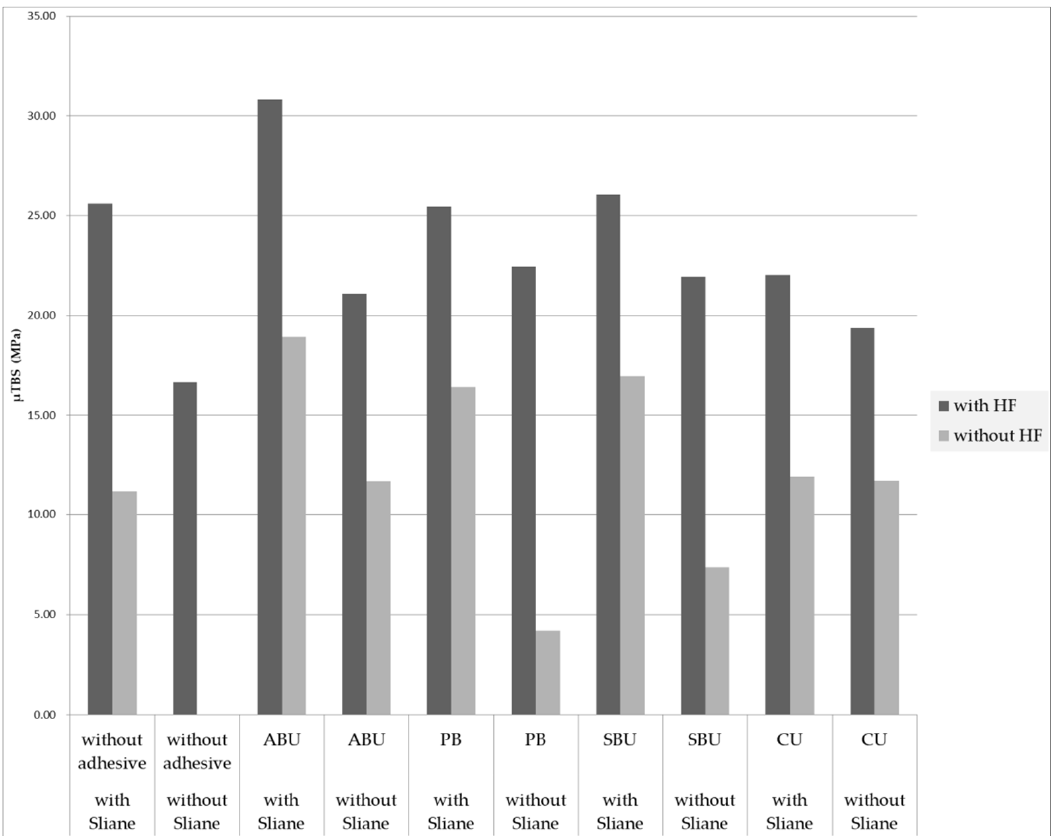
Figure 5. Graph of μ TBS (MPa) according to HF application ( n = 15).